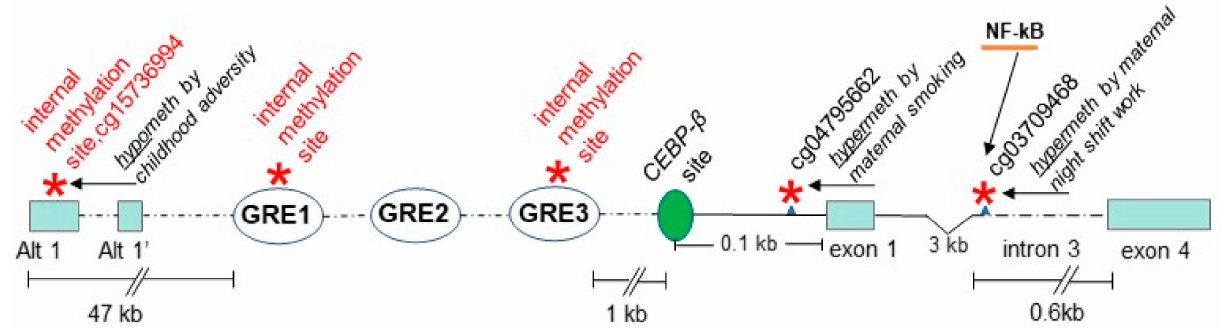
Figure 7. Location of key methylation sites in TDO2 (marked with red asterisks): within alternative exon 1 (Alt-1), in two of the three glucocorticoid motifs and just upstream of exon 1 in the promoter region. Methylation of the GRE sites should enhance binding of the glucocorticoid receptor protein, docking of cortisol to the site [195], and act to increase expression of the gene. The CEBP- β transcrip- tion factor motif identified by Kudo et al. [198] enhances GRE motif effects when both are bound by their respective ligands [197]. Hypomethylation within Alt-exon 1 (cg15736994; see iMethyl for loca- tion) is observed in children who are economically underprivileged [189], and would likely diminish inclusion of the alternative transcript from this location, as methylation within alternative exons can act to enhance inclusion in the final transcript [77]. However, the absolute level of expression may be higher when the hypomethylation is in the first exon [16], thus the net effect cannot be estimated. Hypermethylation of a CpG site just upstream of exon 1 was reported for newborns of mothers who smoked during pregnancy [204]. Chronic mild stress in adult rodents has been shown to decrease methylation in the general region of the promoter [205]. Hypermethylation at a CpG site in intron 3 is found in placental tissue of pregnant women who worked on the nightshift [200]. The transcription factor NF-kB is predicted by the program Alibaba2 to bind at this site, and among other roles, it is involved in response to immune stimuli as well as stress from sleep deprivation [201,206], certainly consistent with nightshift work. Methylation of this NF-kB site would be expected to block NF-kB binding to the motif [202]. Binding of NF-kB to introns has been shown for other genes, e.g., ICAM-1, where its role is generally to stimulate expression